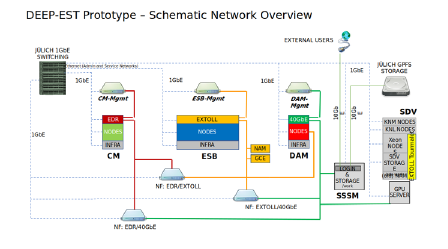
Figure 7: DEEP-EST Prototype Network